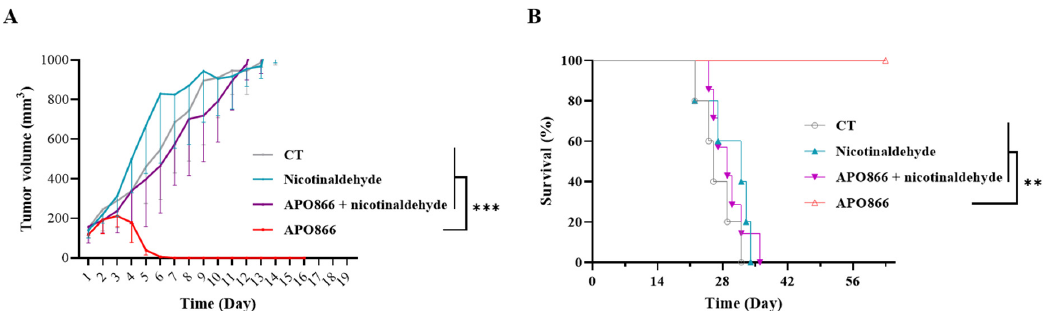
Figure 5. Nicotinaldehyde abrogates APO866 antitumor effect in a mouse xenograft model of human leukemia. ( A ) Evolution of tumor growth and ( B) survival rate of mice xenografted with ML2 cells and treated without or with APO866 in absence or presence of nicotinaldehyde. Control group received vehicle (grey line). Nicotinaldehyde (30 mg/kg; blue line), APO866 (10 mg/kg; red line) or nicotinaldehyde plus APO866 (purple line) were administered as described in “Materials and Meth- ods”. Day 1 corresponds to the beginning of the treatment (when tumor volume reached >100mm 3 ) ( A ) or the day of tumor injection ( B ). n = 5 per group, error bars = SD. ** P < 0.01, *** P < 0.001. Data were analyzed by Kaplan–Meier survival analysis with log ‐ rank test.